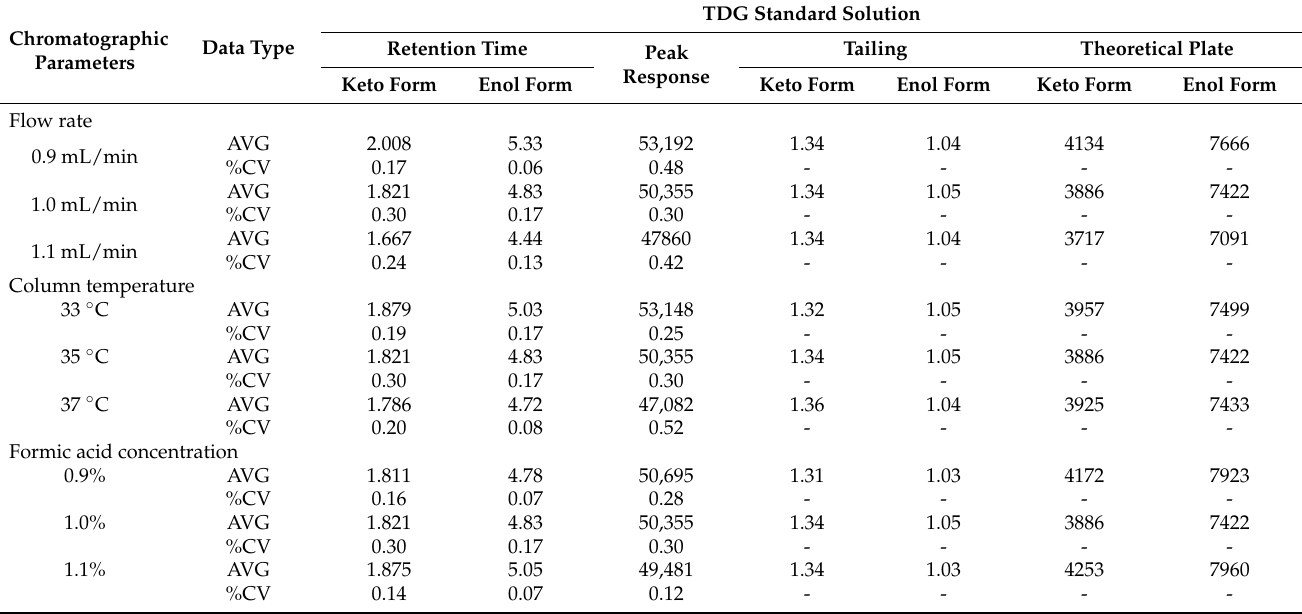
Table 5. The robustness of the method ( n =